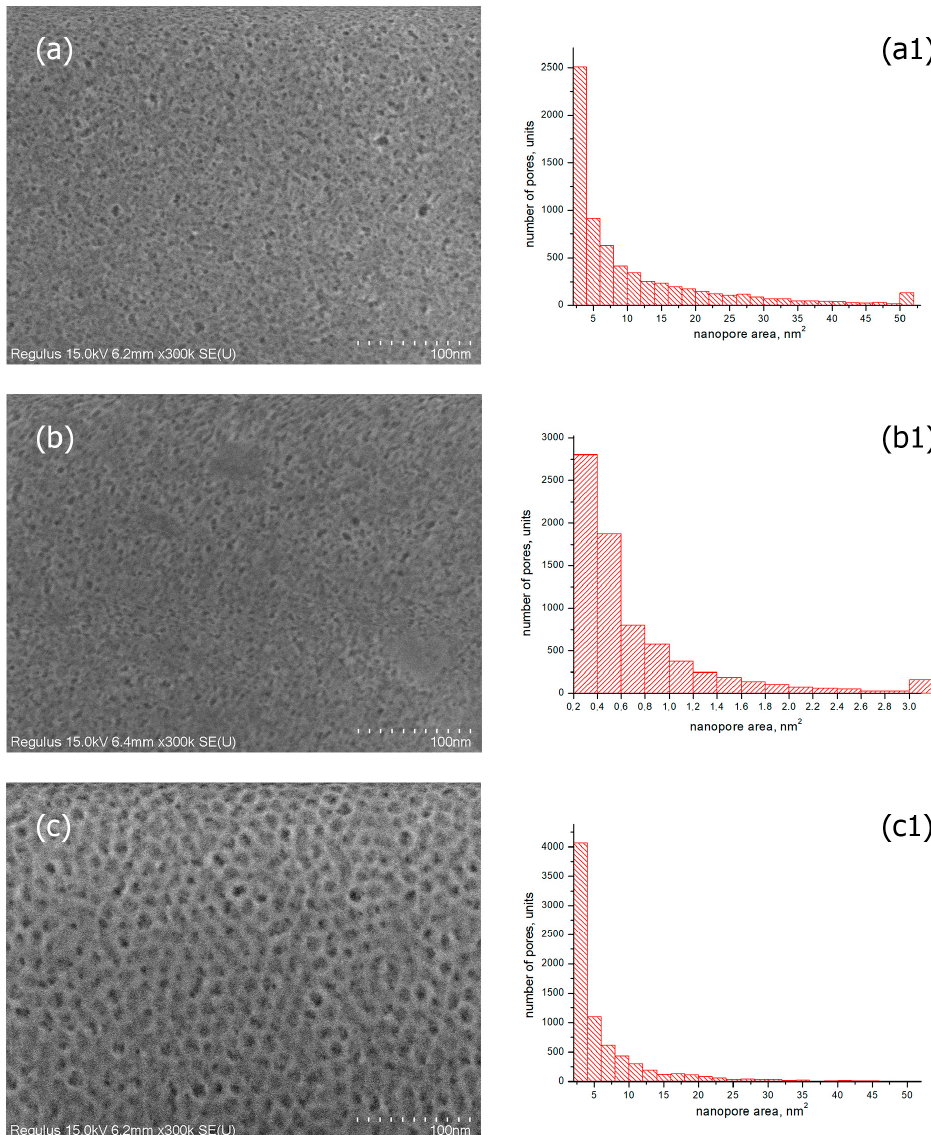
Figure 4. SEM images of silicate glass with the coatings obtained from sols of silicon dioxide with the addition of ( a ) TBAB (5 wt.%), 200 ◦ C; ( b ) TBAB (5 wt.%)/gold nanoparticles 2.6 × 10 − 9 mol/mL, 200 ◦ C; ( c ) F-127 (3 wt.%), 400 ◦ C; (the corresponded images ( a1 – c1 ) are the histograms of particle size